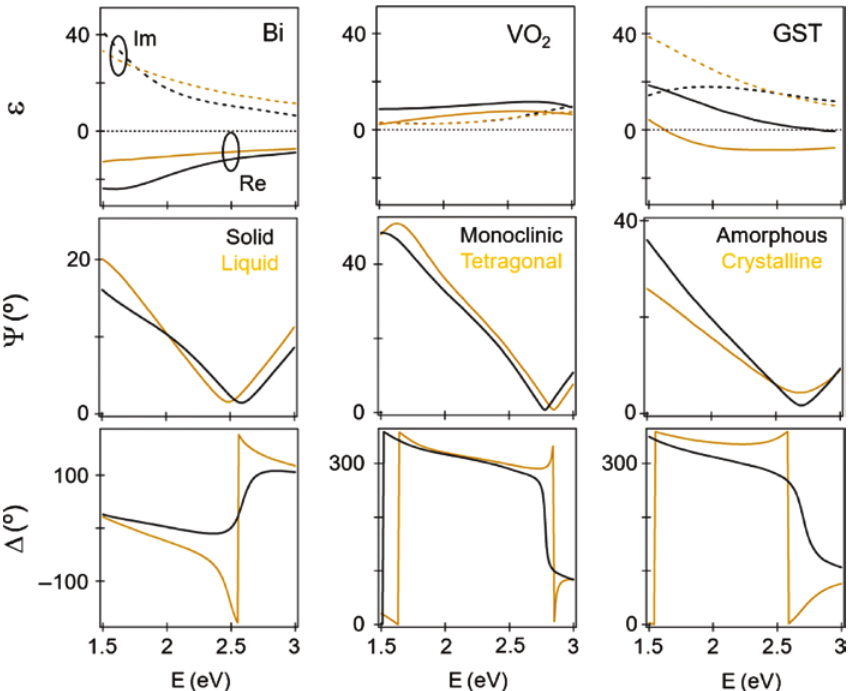
- and GST-based PCMs with the same layered structure as in Figure 2A, before/after the Figure 6: The simulated ψ and Δ spectra of Bi-, VO 2 complete phase transition of the active material (black lines/orange lines) i.e. with solid/liquid Bi nanostructures, monoclinic/tetragonal VO nanostructures and amorphous/crystalline GST nanostructures, respectively. 2 The simulations were done in the transfer matrix formalism (WVASE32 software). The three PCMs had the same layer thicknesses as those used for the ellipsometry analysis in Figure 2C. The composite nanolayers in the three PCMs (Bi:Al respectively) were considered to present the same structure, and were thus modeled with the Bruggeman model with the same volume fraction (f = 37.6%) and depolarization factor (L = 0.48). These values were chosen because they enable the simulated ψ and Δ spectra of the Bi-based PCM to be in good qualitative agreement with the measured ones. The dielectric functions taken from the literature for Bi [25, 27], VO [44] and Ge Sb Te [45] are shown in the first row. The previously determined dielectric functions were used for Si and Al 2 2 2 5 The simulated ψ and Δ spectra shown in the second and third rows have been taken at AOIs of 65.5 ° , 75 ° and 69.5 ° , respectively. These AOIs are those where the PCMs present a near-cancelation of ψ (R ) in the visible p